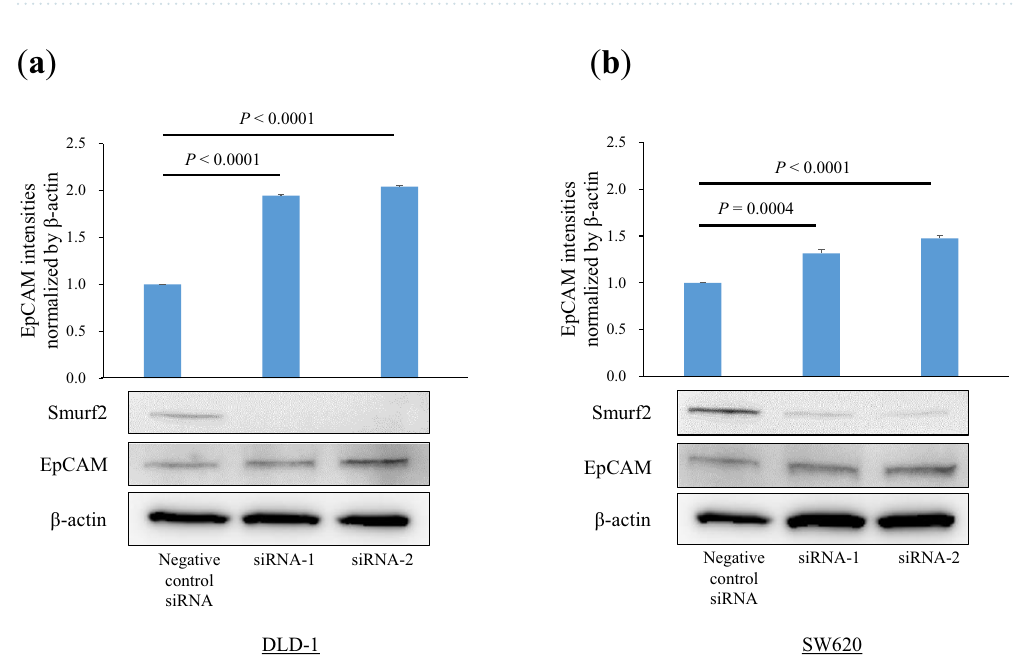
Figure 4. Western blot analyses for epithelial cell adhesion molecule (EpCAM) protein expression. Western blot analysis was performed to evaluate EpCAM protein expression in ( a ) human colon cancer cell line DLD-1 cells and ( b ) human colon cancer lymph node metastasis cell line SW620 cells treated with siControl and